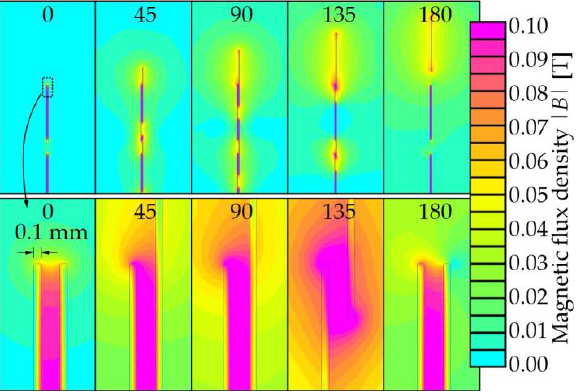
Figure 12. HTS windings of the SFCL.